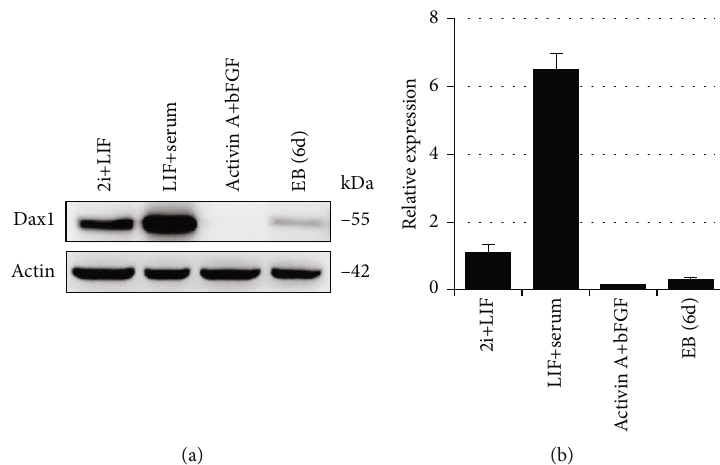
Figure 1: The expression level of Dax1 in 2i/LIF-ESCs is much lower than that in LIF/serum-ESCs. (a) Western blot analysis shows the expression of Dax1 in ESCs in di ff erent culture conditions. (b) Quantitative real-time PCR analysis shows the transcription level of Dax1 in di ff erent culture conditions. Data are the averages of biologicaltriplicates ± standard errorof the mean ð SEM Þ .